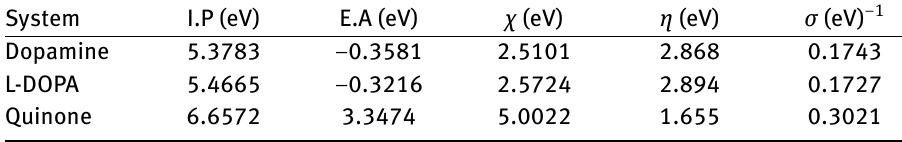
Table 1: The values of ionization potential (I.P), electron aflnity (E.A), Mulliken electronegativity ( χ ), hardness ( η ), and softness ( σ ).